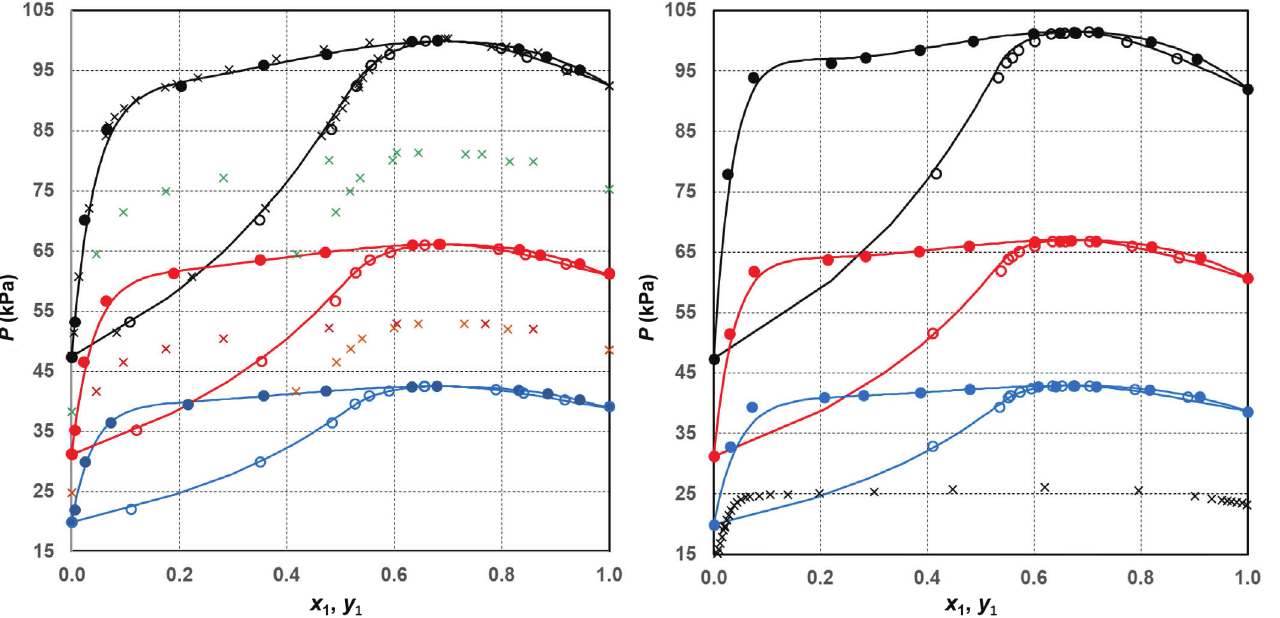
Fig. 2 – Vapor-liquid equilibrium in the 2-methylpropan-2-ol + water (2) system. Experimental points: (  ,  ) 333.15 K, (  ,  ) 343.15 K, (  ,  ) 353.15 K, × 323.15 K (ref 7 ). Lines represent NRTL correlation.